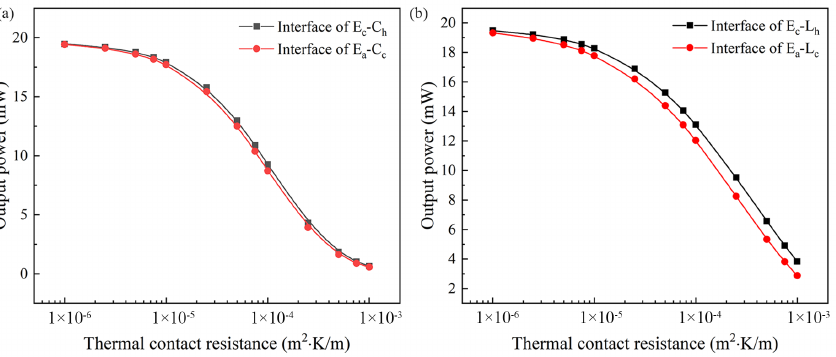
Figure 8. Relationship between interface thermal resistance of ( a ) the central electrode, ( b ) the surrounding electrode, and output